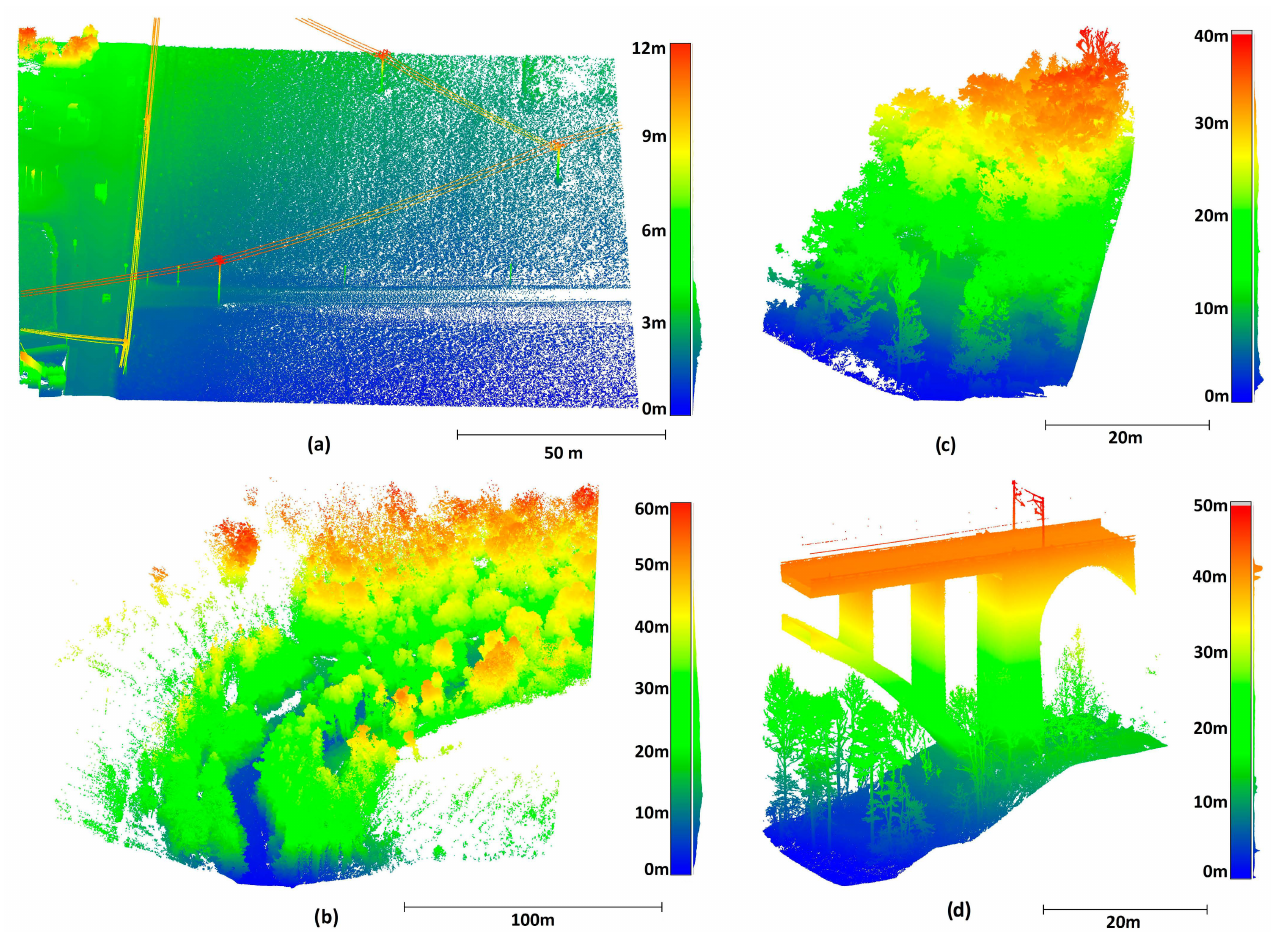
Figure 4. Testing point clouds colored by relative height: ( a ) site 1, ( b ) site 2, ( c ) site 3, and ( d ) site